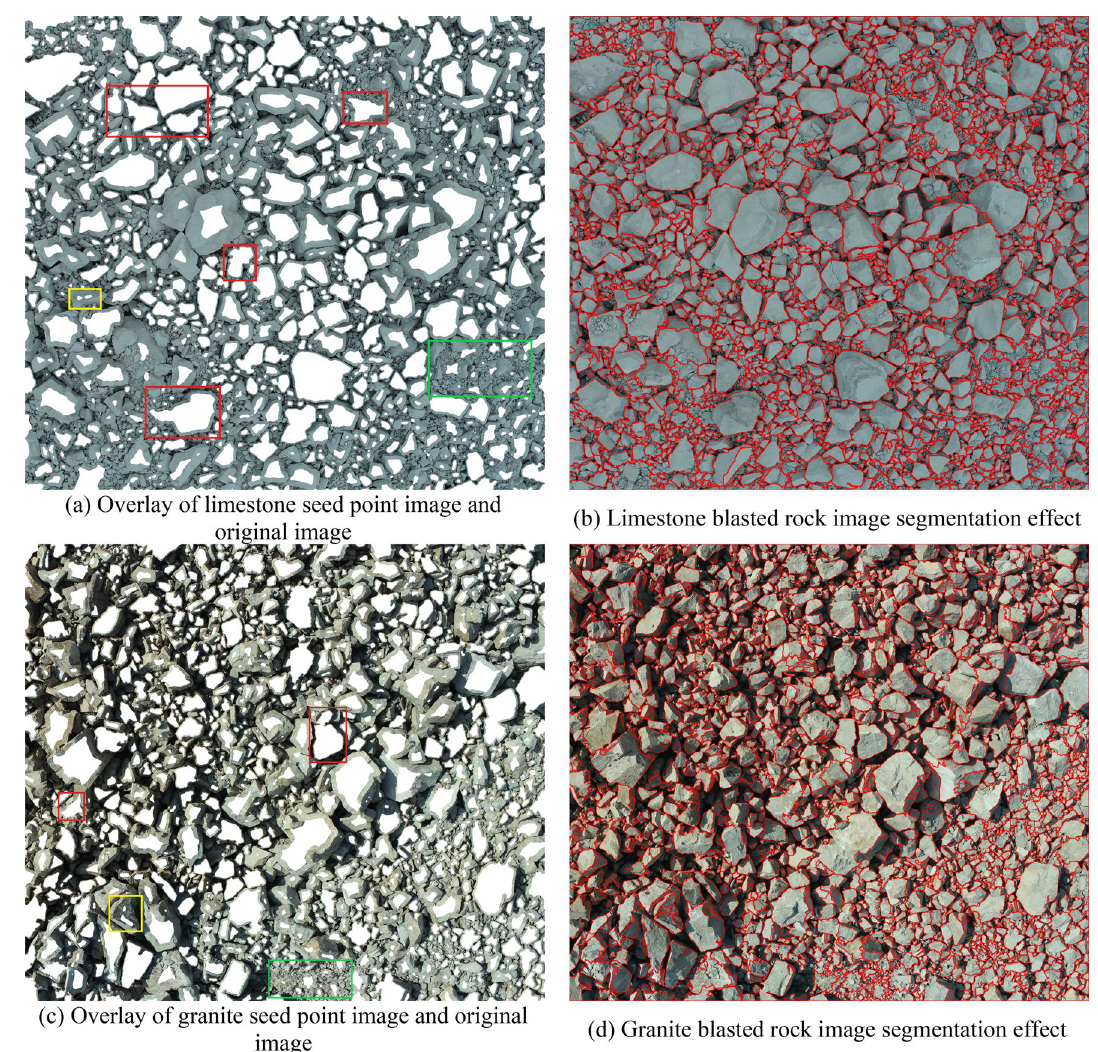
Figure 17. Blasted rock seed point marking effect and segmentation effect for a solidity threshold of